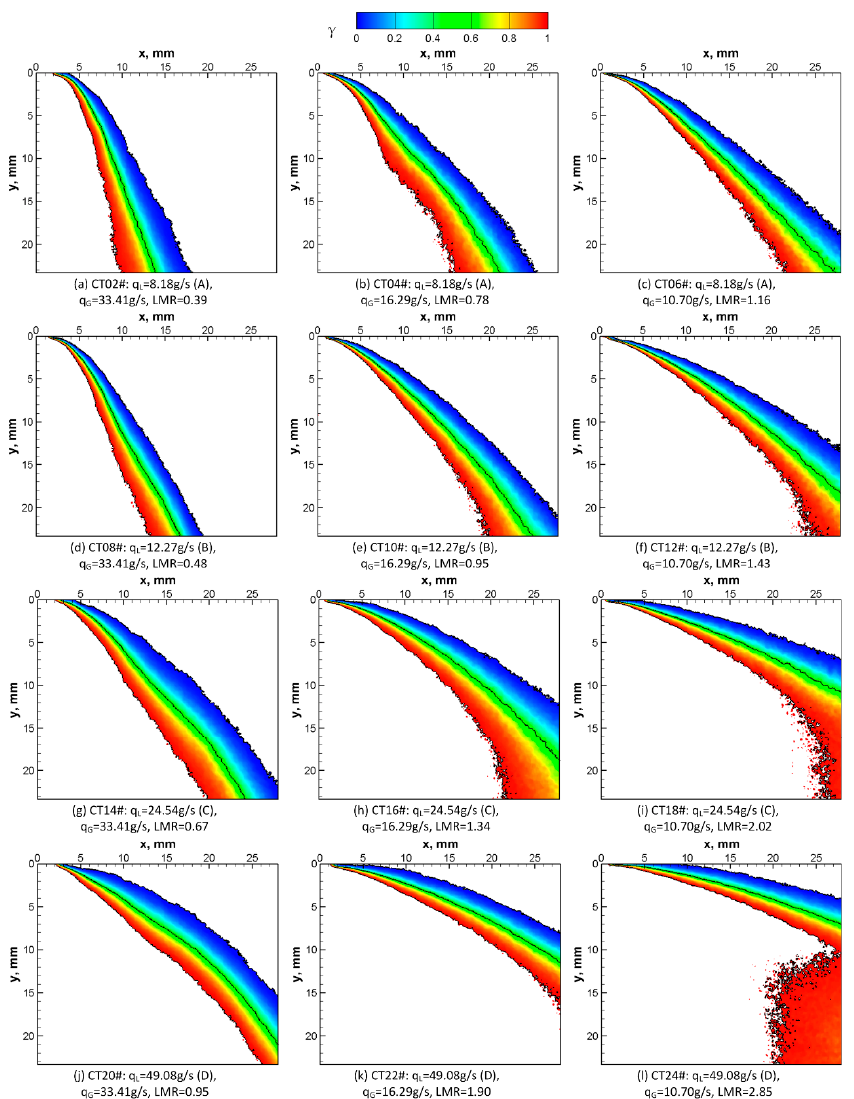
Figure 7. Spray windward boundary bands for various operating conditions; superimposed on the contour are the spray fraction isolines ( γ = 0, γ = 0.5, and γ = 1).